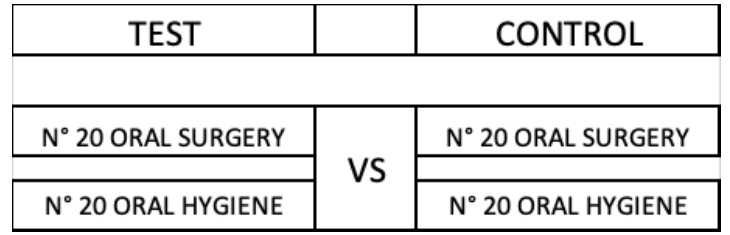
Figure 1. Test groups versus control groups.